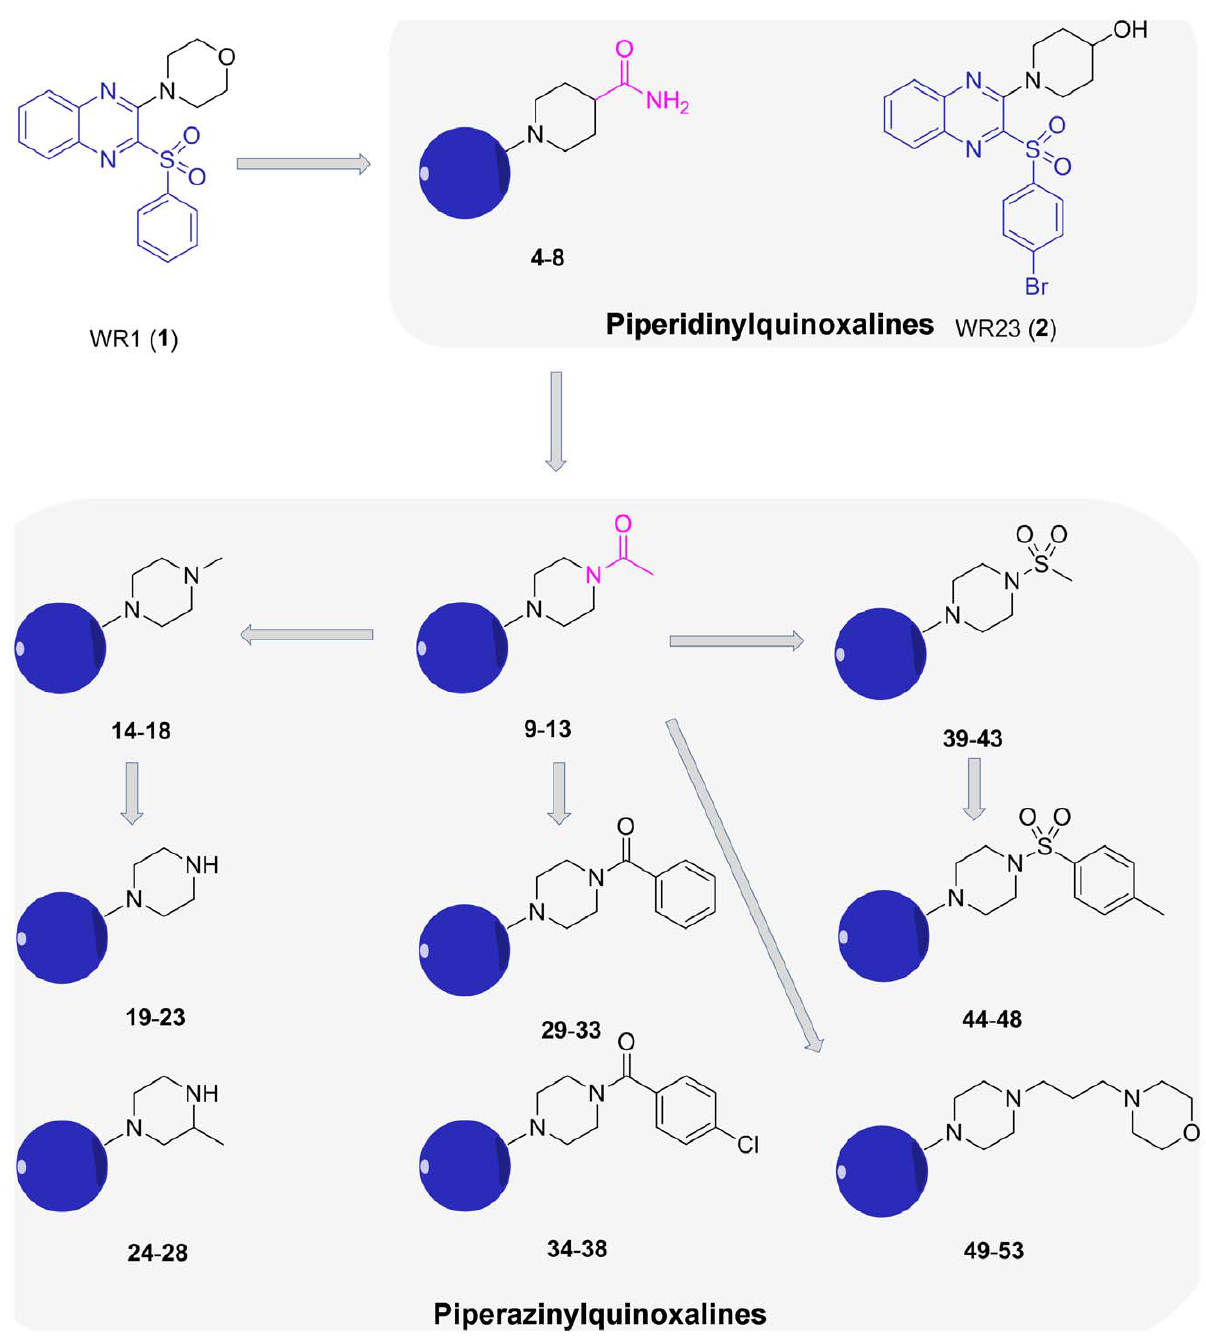
Figure 2. The modification and optimization journey from WR1 to target piperazinylquinixaline derivatives. Blue circles of compounds 4–53 stand for an arylsulfonylquinoxaline